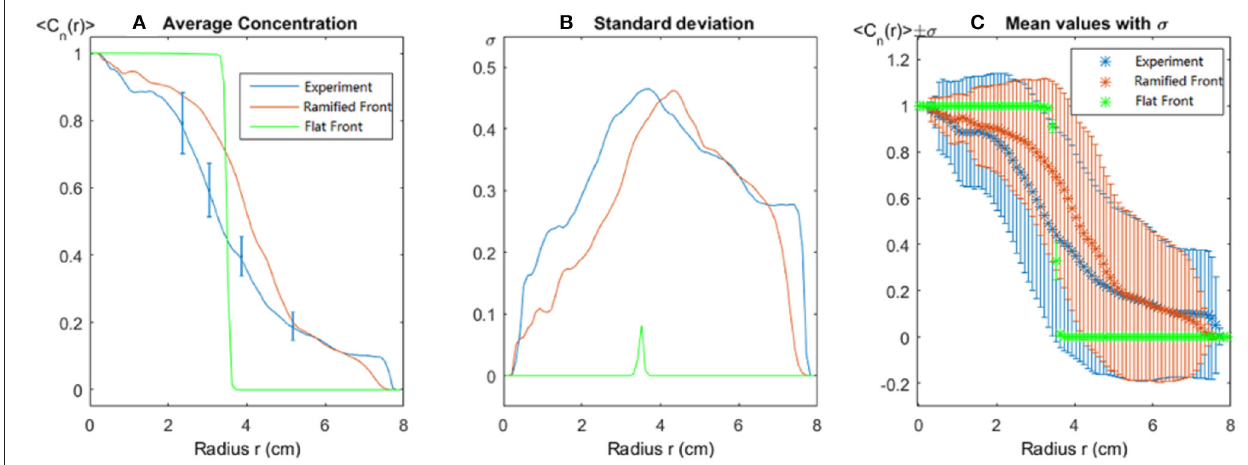
FIGURE 8 | Spatial dependence of structure as function of the circle radius. (A) The normalized average concentration, the error bar comes from experimental measurement for fluid tracer concentration according to the calibration performed in Supplemental Data. (B) Its standard deviation and (C) mean values with error bars at one standard deviation. In all cases, the blue line is the experimental result, the red line corresponds to the simulation with an injection ramified front corresponding to the dissolution pattern present in this experiment, and the green line represents the simulation result with an internal flat (circular) front of similar area.